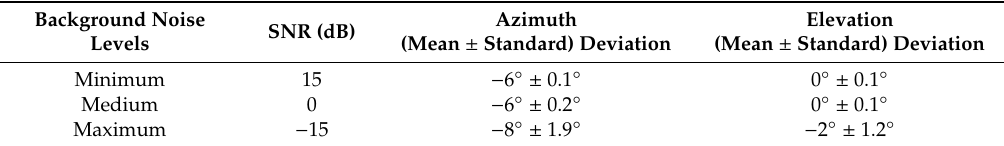
Table 2. Accuracy data obtained for setup 2 tests.